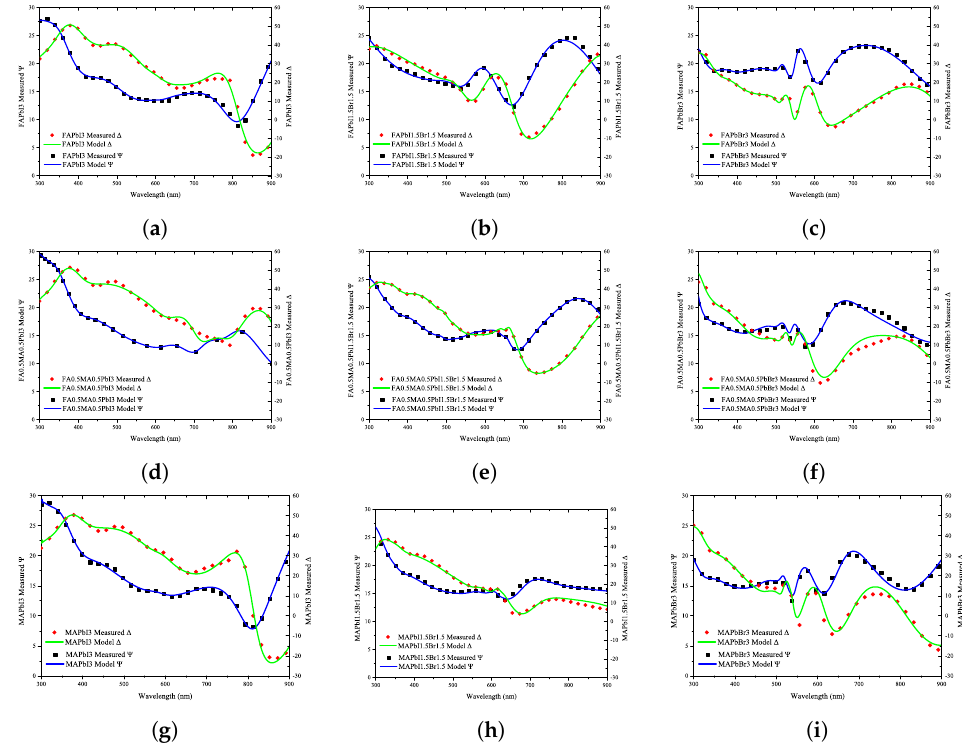
Figure 5. Measurement results using ellipsometry analysis of quaternary perovskite materials and optical simulation results: ( a ) FAPbI 3 , ( b ) FAPbI 1.5 PbBr 1.5 , ( c ) FAPbBr 3 , ( d ) FA 0.5 MA 0.5 PbI 3 , ( e ) FA 0.5 MA 0.5 PbI 1.5 Br 1.5 , ( f ) FA 0.5 MA 0.5 Br 3 , ( g ) MAPbI 3 , ( h ) MAPbI 1.5 Br 1.5 , ( i ) MAPbBr 3